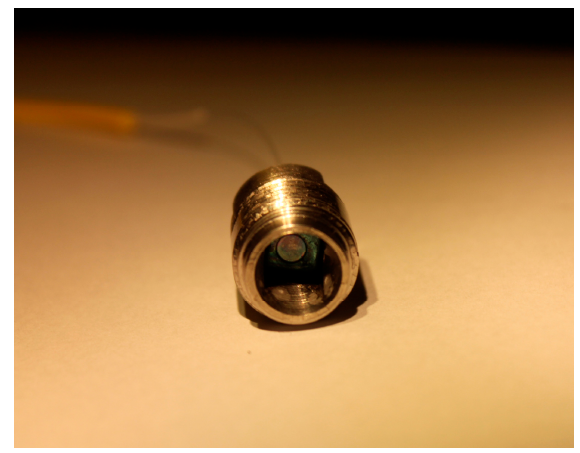
Figure 7. The fiber-optic pressure sensor with a full SiC sensor head.